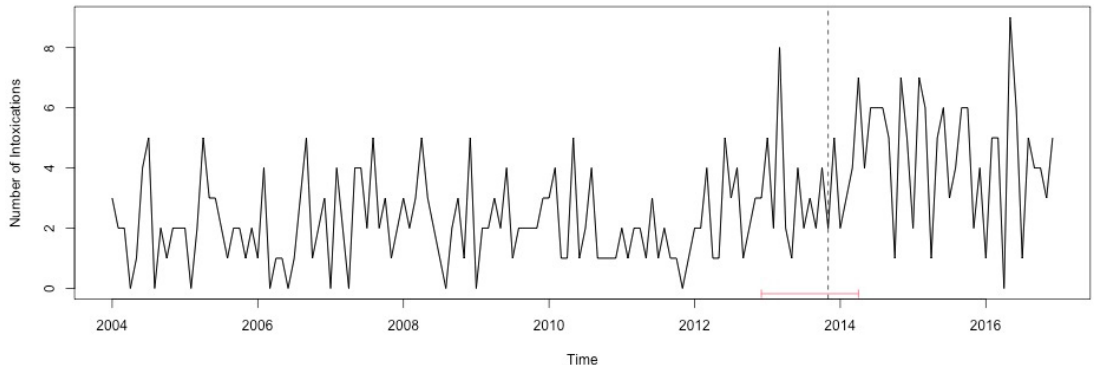
Figure A50. Heroin organized crime neighboring countries nationals arrests 2004–2016 in the Czech Republic and structural breaks.